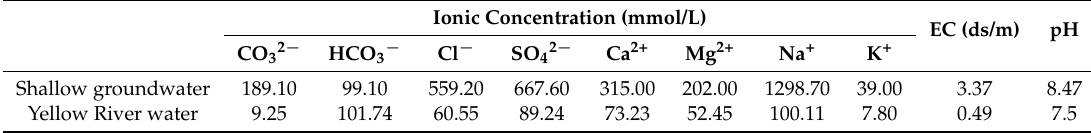
Table 4. Compositions of shallow groundwater and Yellow River water. Table 4 . Compositions of shallow groundwater and Yellow River water. Table 4 . Compositions of shallow groundwater and Yellow River water.